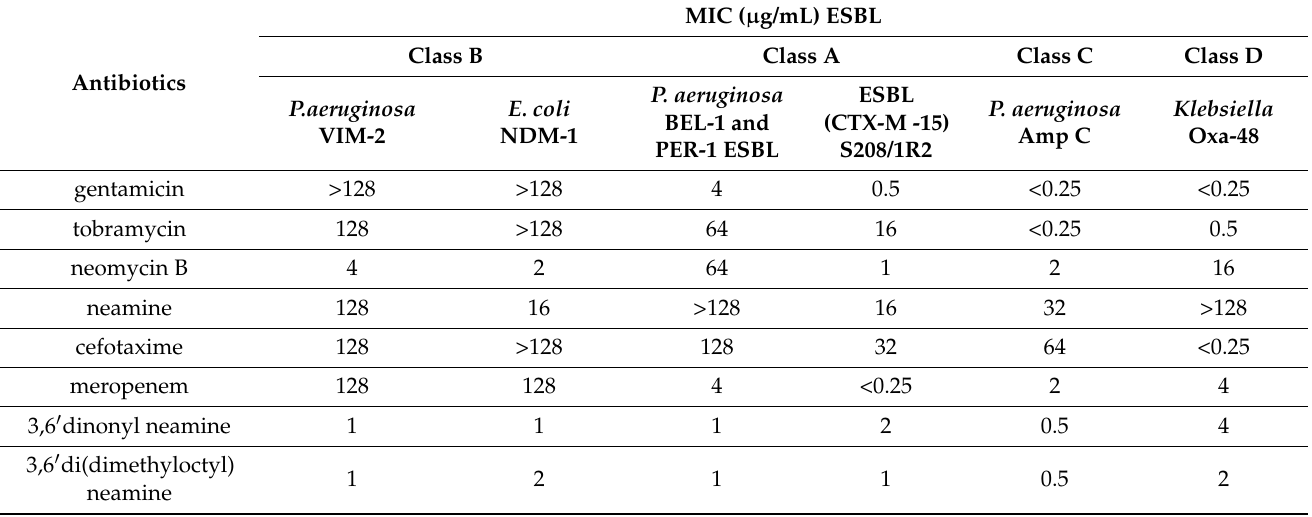
Table 2. MICs of 3 (cid:48) ,6-dinonyl neamine and 3 (cid:48) ,6-di(dimethyloctyl) neamine against strains expressing β -lactamases in com- parison with those of gentamicin, tobramycin, neomycin B, neamine, cefotaxime, and meropenem. CLSI 2020 breakpoints for P. aeruginosa ; gentamicin R ≥ 16, tobramycin R ≥ 16, cefotaxime (not defined), meropenem R ≥ 8. Enterobacteriaceae ( E. coli and K. pneumoniae ); gentamicin R ≥ 16, tobramycin R ≥ 16, cefotaxime (R ≥ 4), meropenem R ≥